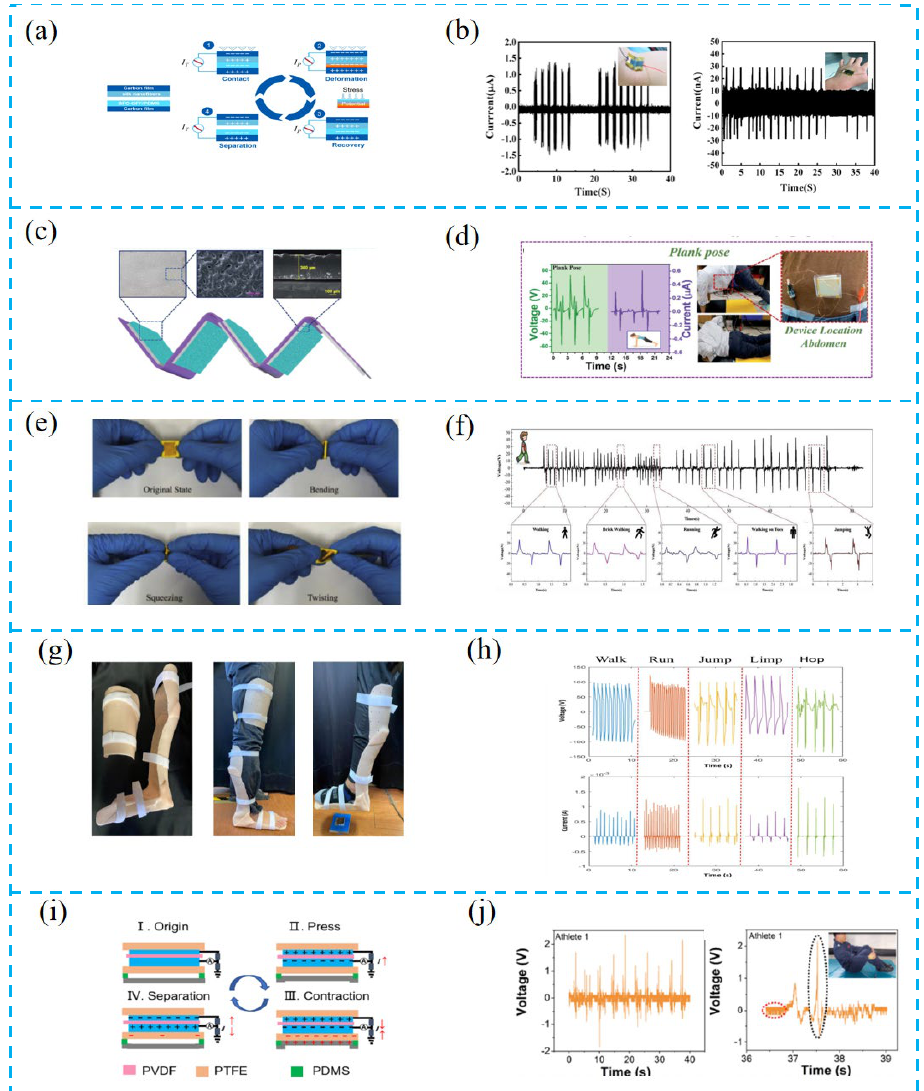
Figure 7. ( a ) Device configuration of PTCNG and working mechanism of PTCNG. ( b ) Output current of the PTCNG for real-time posture monitoring and harvesting body-motion energy. Inset shows the corresponding photography images for the tests. ( c ) Schematic representation of multi-stack PTCNG along with the digital picture of rough film, surface morphology of rough film, and cross-sectional image of the film. ( d ) Demonstration of body activity counter with various yoga movements for calculating the calories burnt. ( e ) Photographs of the HPTS under different deformations. ( f ) The HPTS could monitor the human posture. ( g ) Response to different types of action modes while wearing a leg rehabilitation device. ( h ) The data on the output of five different action modes (walk, run, jump, limp, hop) while wearing a rehabilitation device. ( i ) Coupling mechanism of TENG and PENG. ( j ) Output voltage and details of athlete 1’s 301C diving motion, and output voltage and details of athlete 2’s 301C diving motion. Wireless Bluetooth transmission